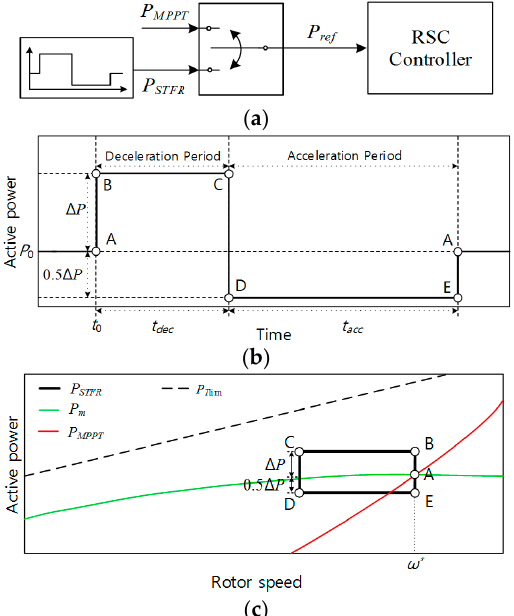
Figure 2. Operational characteristics of Scheme #1 [10]. ( a ) Control scheme of Scheme #1; ( b ) P STFR of Scheme #1; ( c ) P ref − ω r trajectory of Scheme #1. P 0 : power reference prior to an event; P STFR